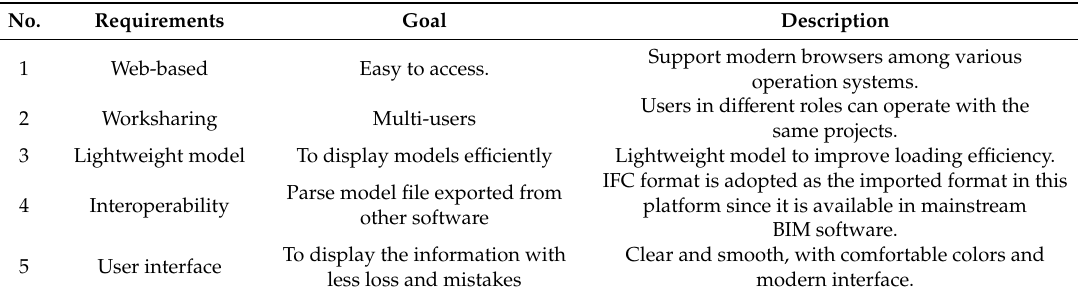
Table 1. Non-functional requirements.